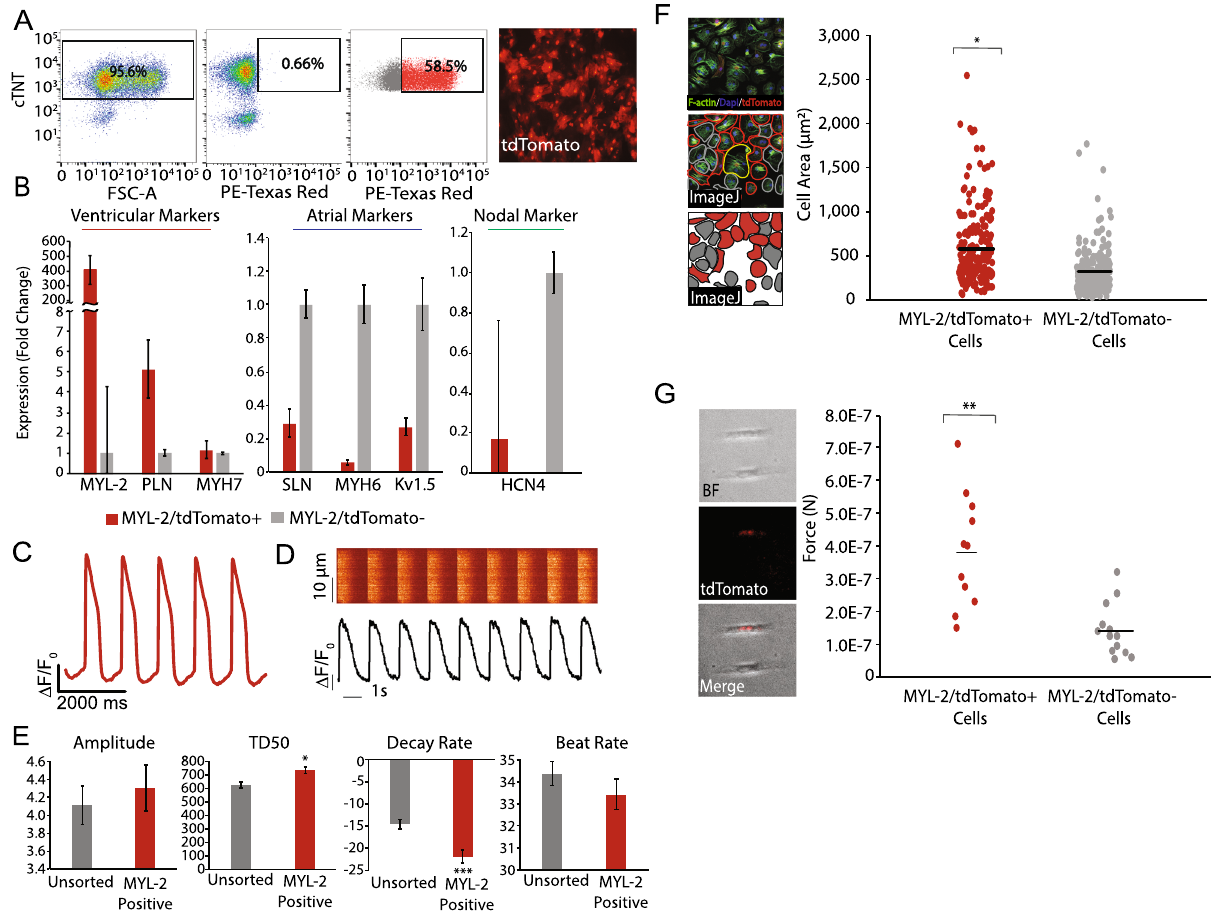
Figure 3. Characterization of the ventricular human iPSC reporter line. ( A ) Representative FACS plots from day 30 cardiomyocytes, depicting the percentage of cells that are cTNT(+), control wild-type cells tdTomato(−), and MYL-2/tdTomato(+) within the cTNT(+) population after sorting. Representative image (right) of sorted MYL-2/tdTomato(+) cells 5 days after sort. ( B ) Real-time PCR of sorted MYL-2/tdTomato (+) cells (day 45) normalized to GAPDH (ΔCT) and tdTomato(−)(ΔΔCT) population (n = 5). ( C ) Representative action potential tracing of MYL-2/tdTomato(+) cells (day 30) using voltage activated fluorescent dye (n = 8). ( D ) Representative calcium tracing and quantification of amplitude, TD50, decay rate, and beat rate of MYL-2/tdTomato(+) cells (day 30) (n = 3). ( E ) Size quantification of day 30 cardiomyocytes, stained for F-Actin (green), Dapi (blue), and fluorescence from MYL-2/tdTomato+ (red) (n = 100). ( F ) Single cell force generation study using traction force microscopy. Images depicting the micropatterned cells (n =